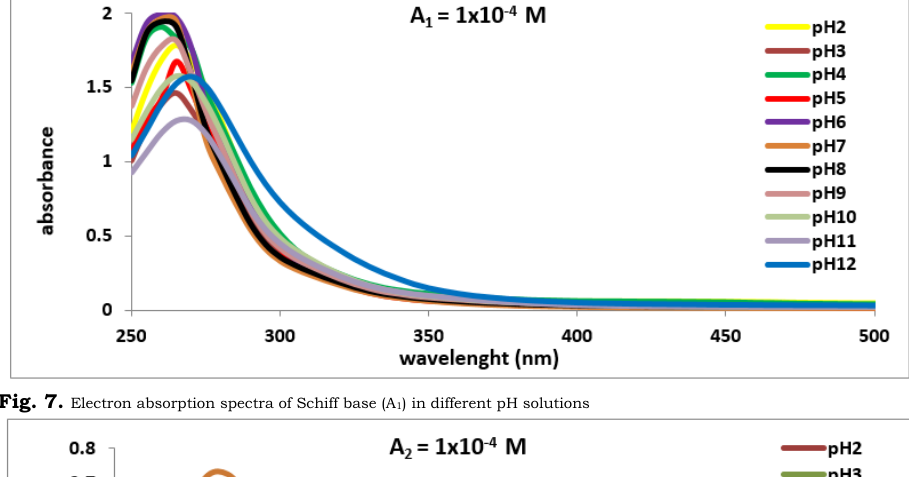
Fig. 7. Electron absorption spectra of Schiff base (A 1 ) in different pH solutions